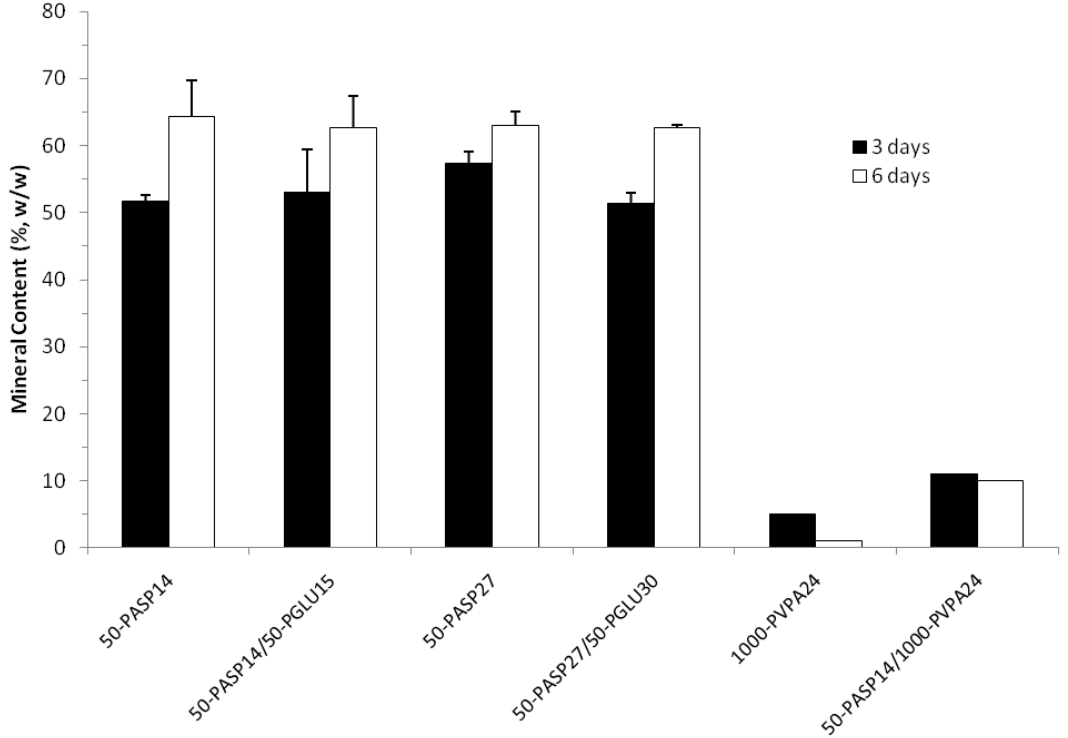
Figure 9. Mineral content of collagen sponges mineralized via the polymer-aided process. PILP-mineralized collagen samples treated with 50 µg/mL poly-L-aspartic acid, 50 µg/mL poly-L-glutamic acid, 1,000 µg/mL polyvinylphosphonic acid or a combination of polymers for 3 and 6 days. Total percent of mineral present in the samples was determined using thermogravimetric analysis. A heating rate of 5 °C/min was applied in the temperature range of 30–800 °C under air at a flow rate of 100 mL/min. To compare the degree of mineralization, the material remaining at 600 °C was interpreted as the mineral content since the organic portion of the samples should be totally combusted by 600 °C in an oxygen-containing